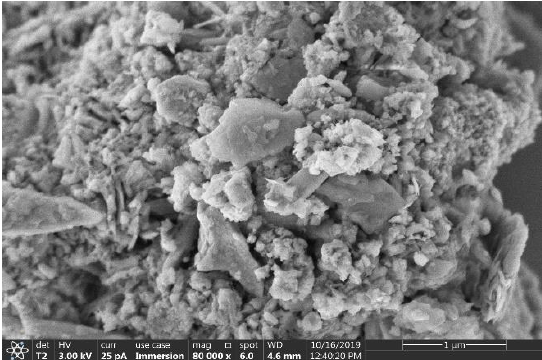
Figure 8. SEM image of representative cement